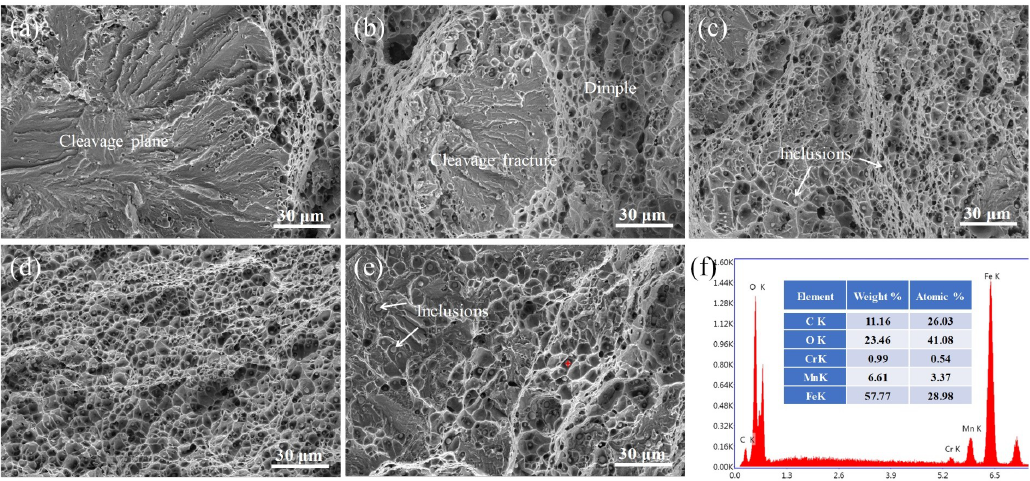
Figure 13. Tensile fracture morphology of joints welded at different ultrasonic output power: ( a ) without ultrasonic, ( b ) 20%, ( c ) 40%, ( d ) 60%, ( e ) 80%, and ( f ) EDS results for the inclusion marked in Figure 13e.